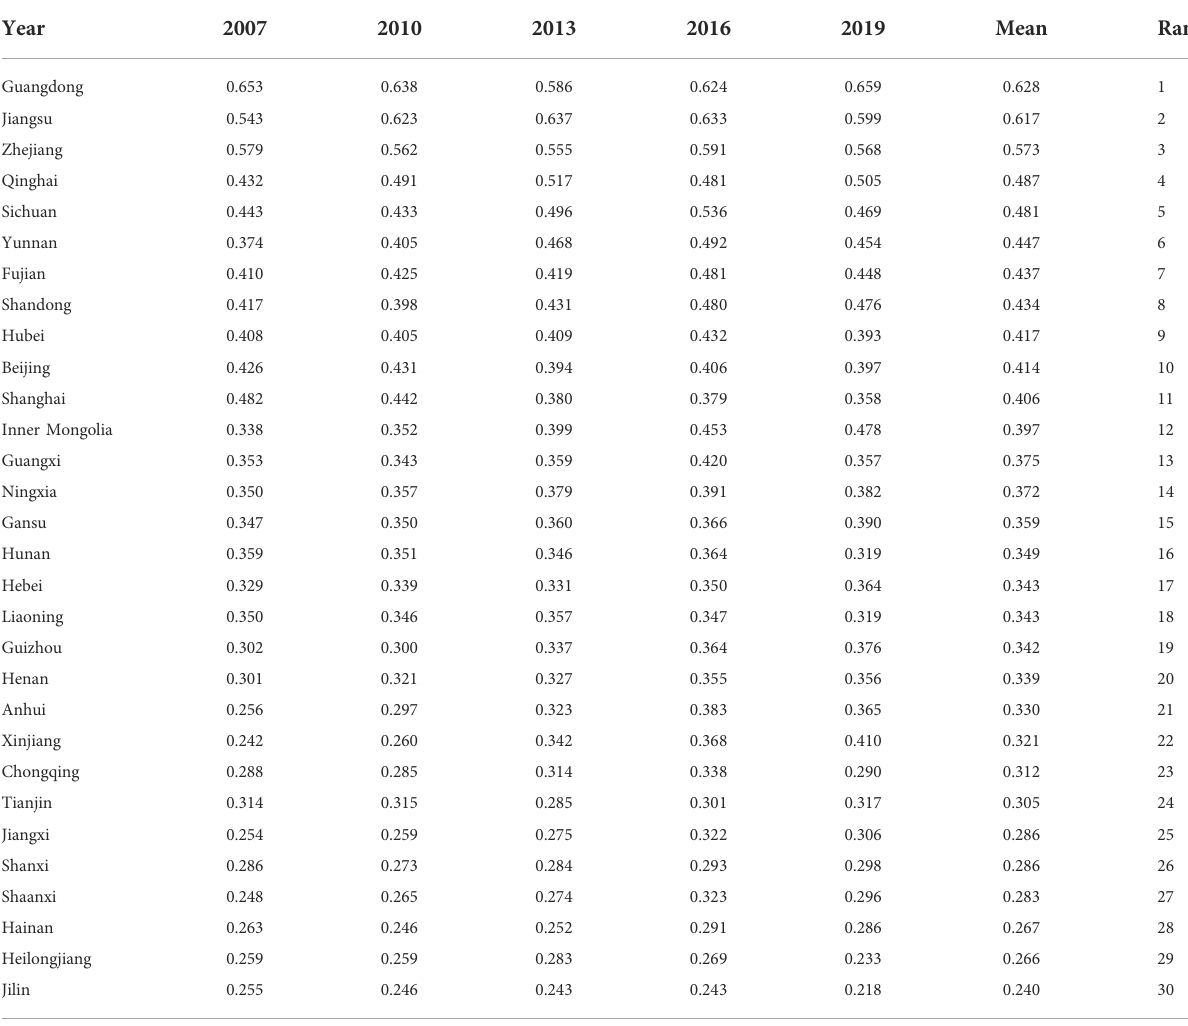
TABLE 2 2007 – 2019 electri fi cation index of